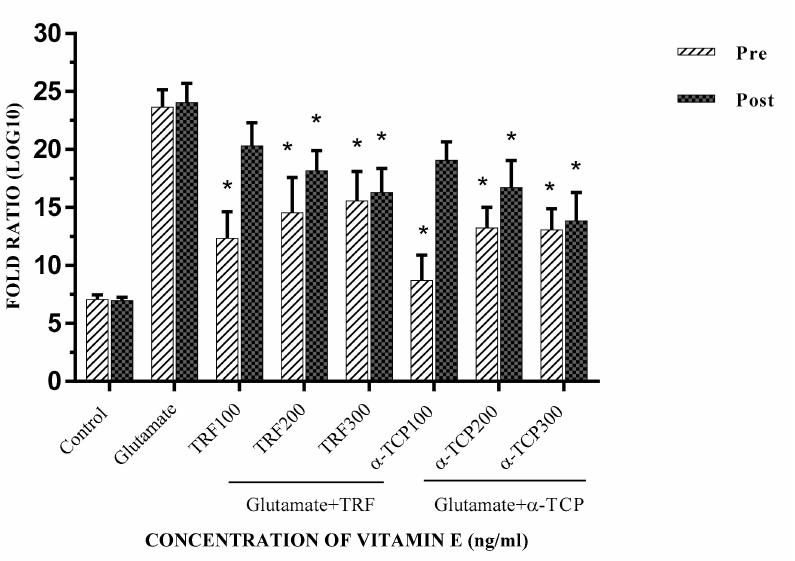
Figure 6. GRIK1 mRNA expression in primary astrocytes with TRF and α -TCP pre-treatment against glutamate insult. Fold change of GRIK1 normalized to ACTB mRNA expression. Data are the mean ± SEM of three independent experiments ( n = 3 in each experiment). * p < 0.05, TRF- and α -TCP-treated groups compared with the glutamate-treated group. Pre- and post-treatment with 100–300 ng/mL TRF and α -TCP significantly reduced the transcription levels of GRIK1 in comparison to the positive control